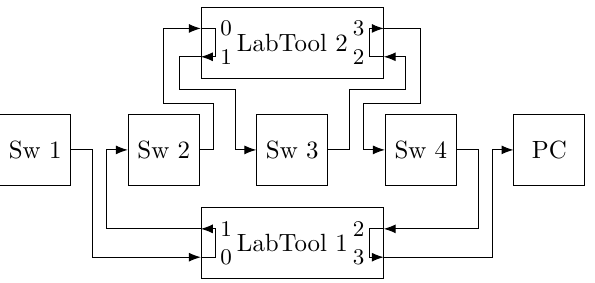
Figure 15. Topology used to measure the end-to-end delay and the jitter in the presence of